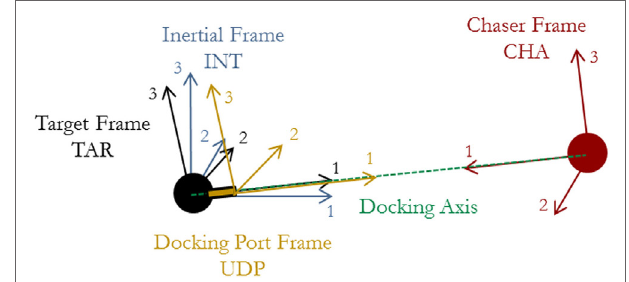
FigUre 1 | Definition of reference